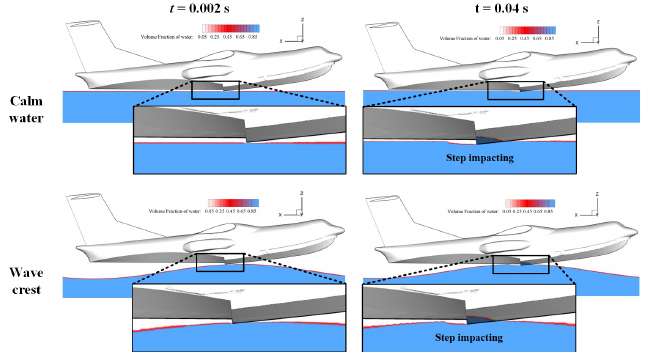
Figure 10. Comparison of aircraft landing in calm water and wave crest during the step impact- ing